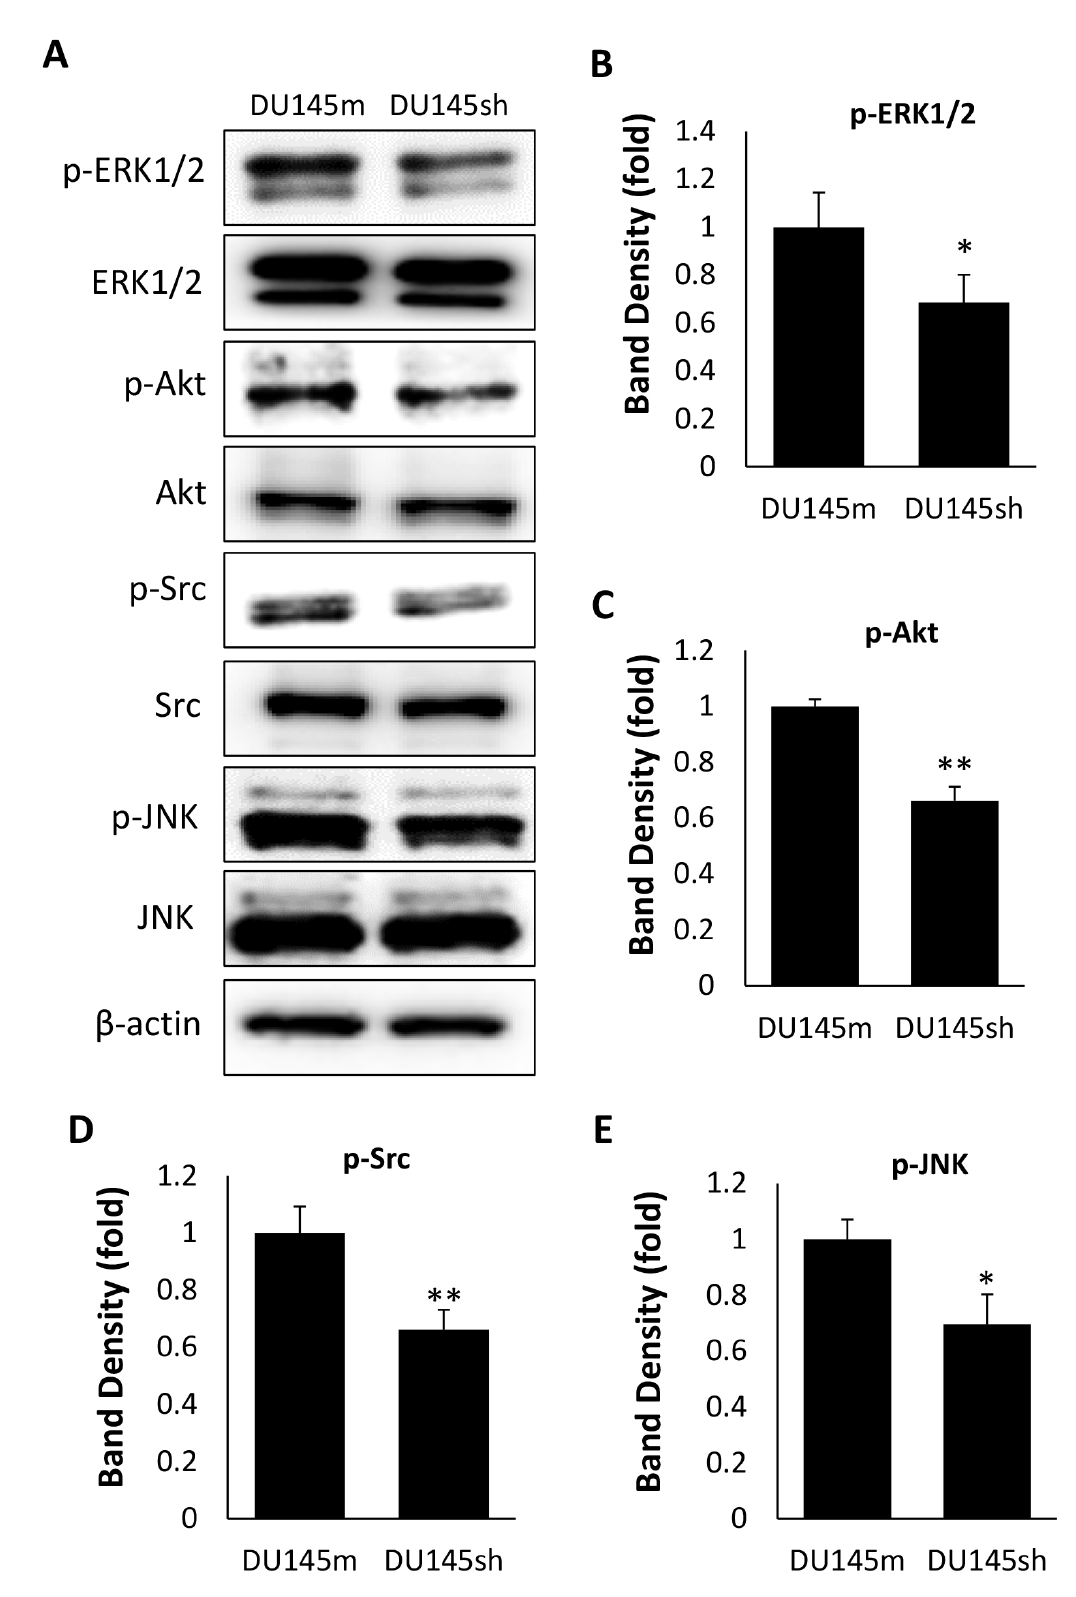
Fig. 3. Knockdown of TRPM7 inactivates ERK1/2, Akt, Src and JNK in DU145 cell line. (A) Representative image of western blot of phospho- and total ERK1/2, Akt, Src and JNK. β -actin served as the loading control. Band intensity of p-ERK1/2 (B), p-Akt (C), p-Src (D) and p-JNK (E) were quantified. All data are expressed as the mean ± standard deviation from three independent experiments. * p < 0.05; ** p < 0.01 versus